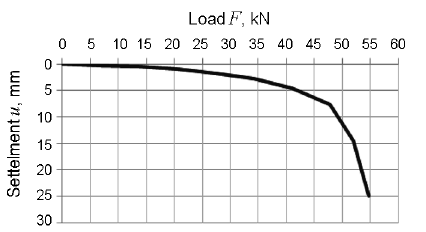
Fig. 5. Pile load versus settlement